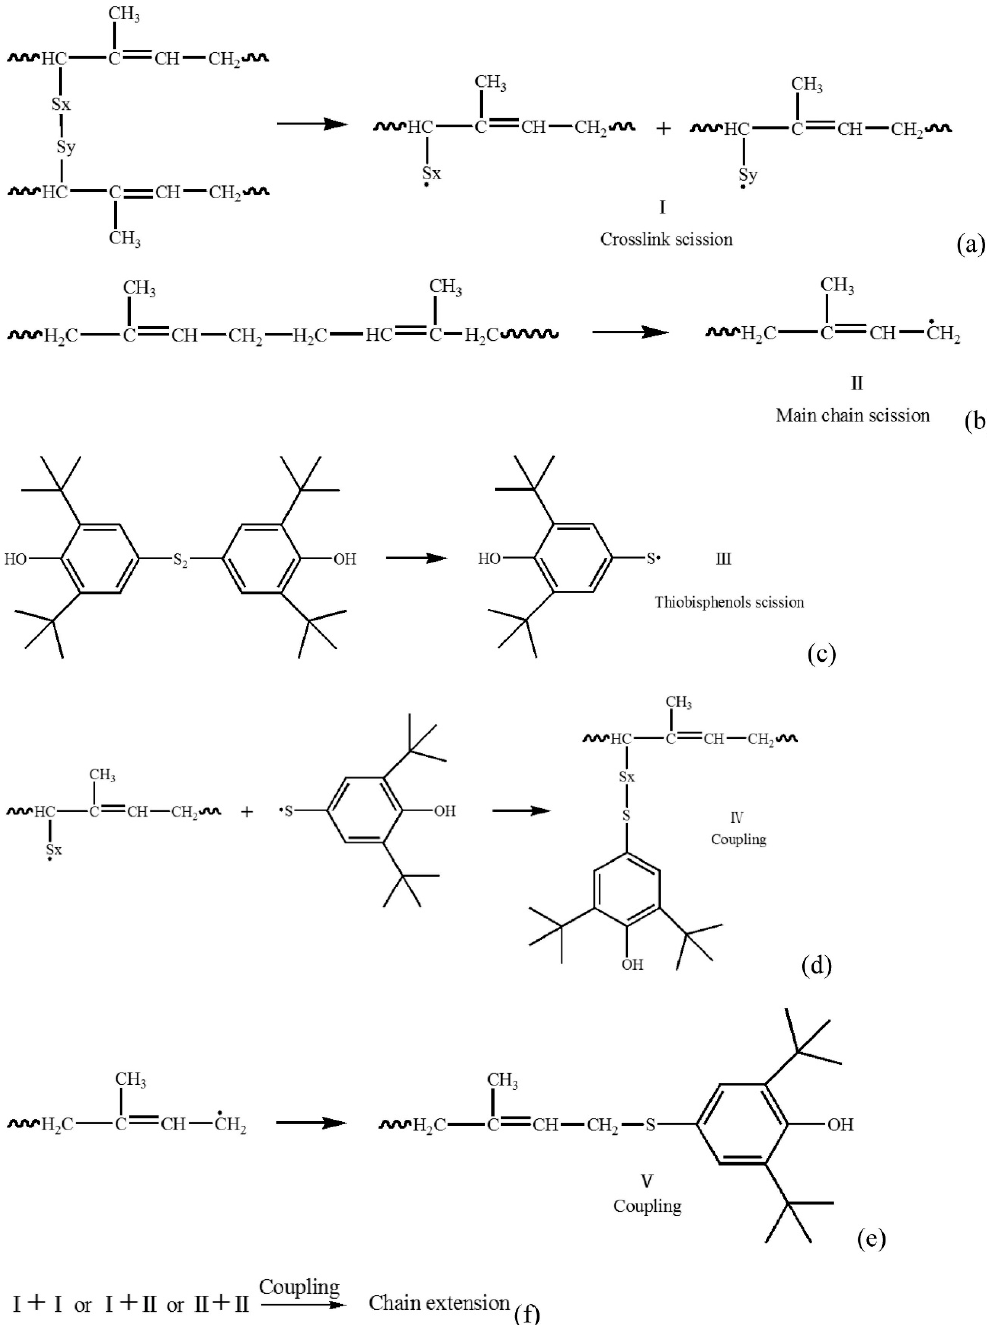
Figure 17. Reaction scheme for the regeneration of sulfur vulcanized rubber with thiobisphenols (reproduced with permission from [97]).